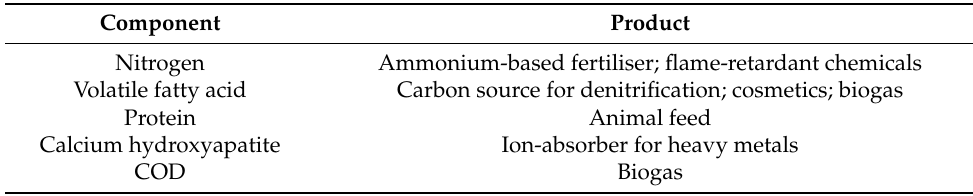
Table 4. Possible products from